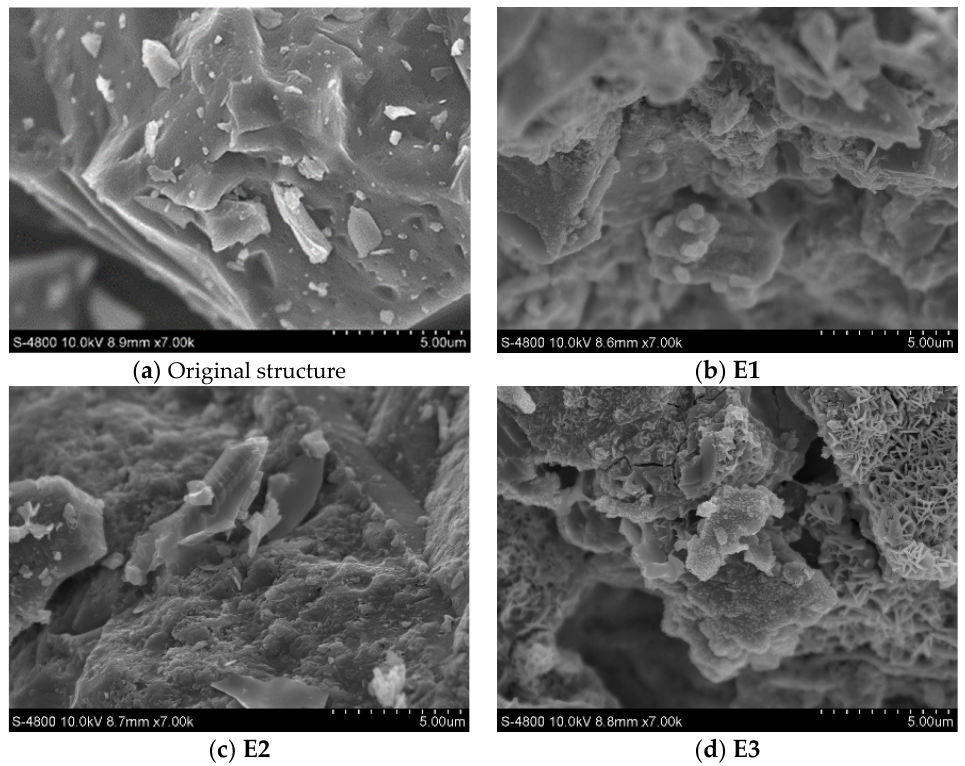
Figure 7. Surface morphologies of the clogging matter. ( a ) Surface morphologies of the sand that has not been irrigated. ( b ) Surface morphologies of the clogging matter in E1. ( c ) Surface morphologies of the clogging matter in E2. ( d ) Surface morphologies of the clogging matter in E3.